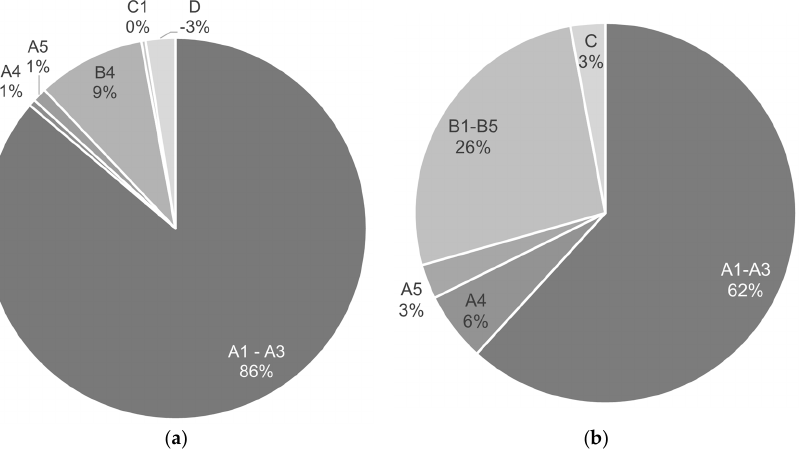
Figure 13. Embodied Carbon Emissions Portions. ( a ) Portlands Place. ( b ) LETI (reproduced from LETI Embodied Carbon Primer,